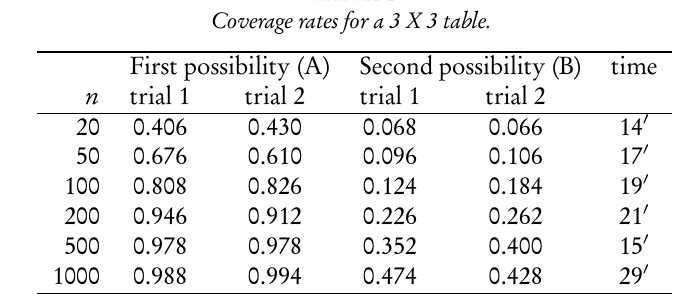
Coverage rates for a 3 X 3 table.